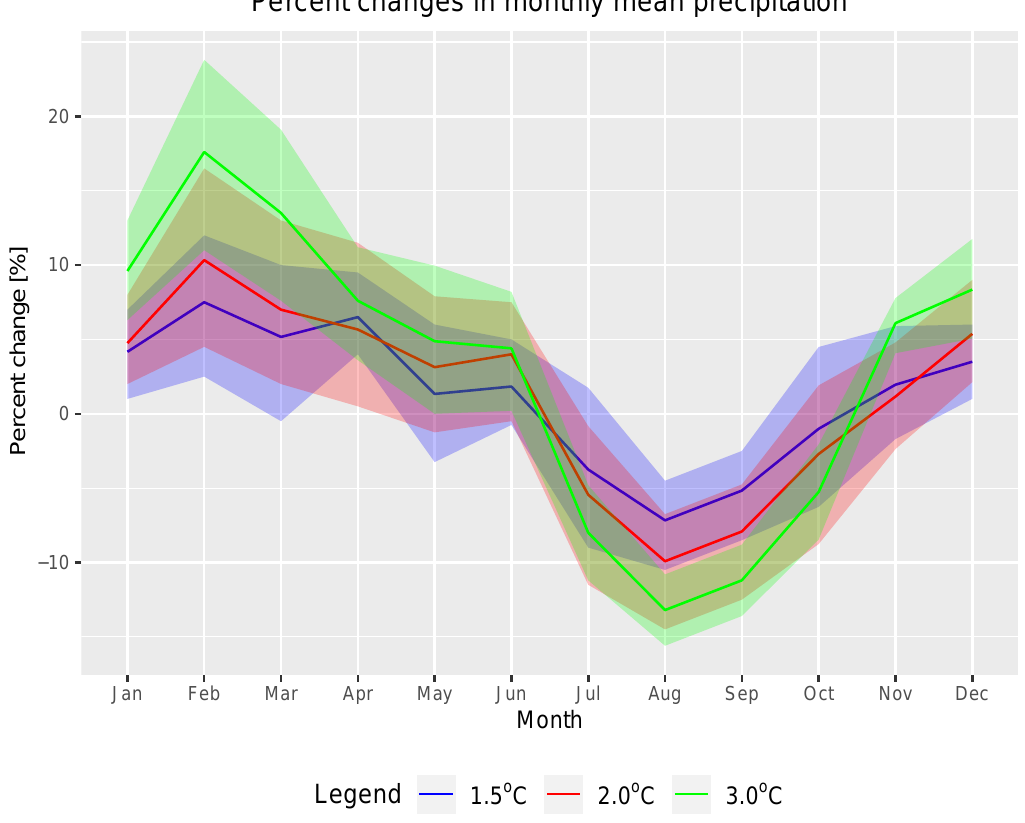
Figure 2. Percent changes in daily mean of monthly precipitation across all eight basins under different levels of temperature increases relative to the base period